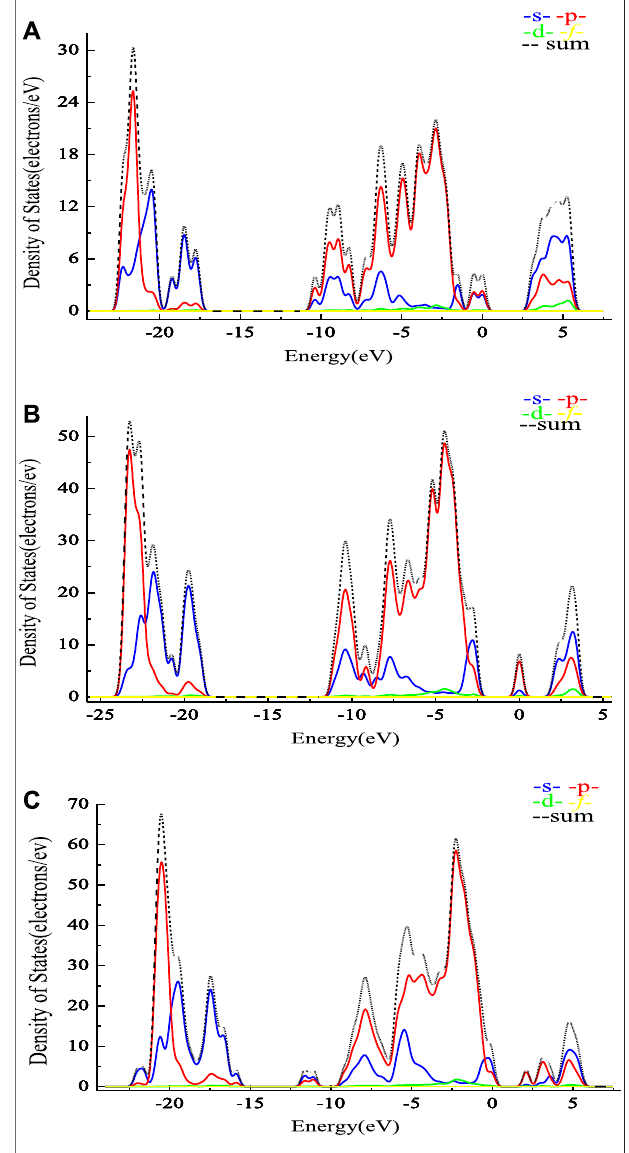
FIGURE4| PDOSanalysisofjennitebeforeandaftertheadsorptionwith sodium tartrate. (A) PDOS analysis of the jennite (020) surface before adsorption. (B) PDOS analysis of the jennite (010) surface before adsorption. (C) PDOS analysis between the jennite (010) and sodium